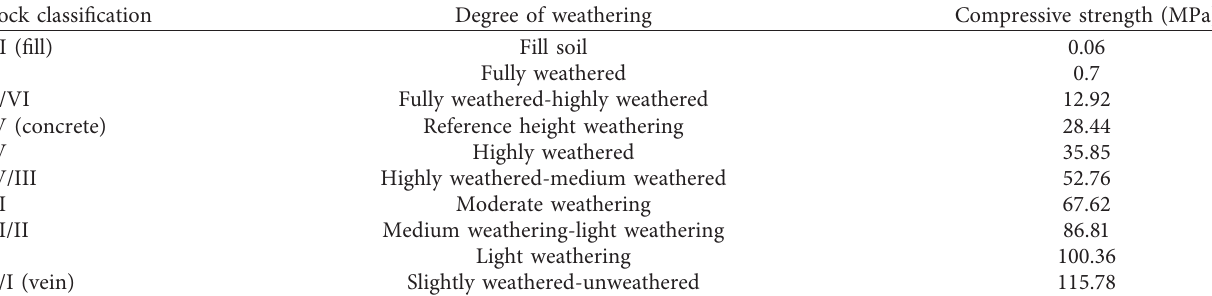
Table 7: Classification and compressive strength of weathered